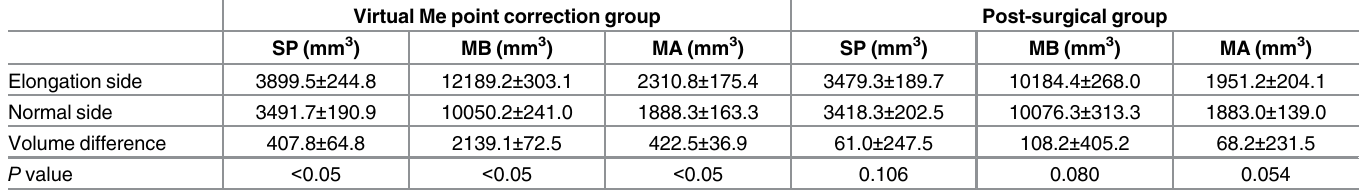
Table 1. The volumetric measurement of the mandibular regions after virtual Me point correction and after clinical orthognathic